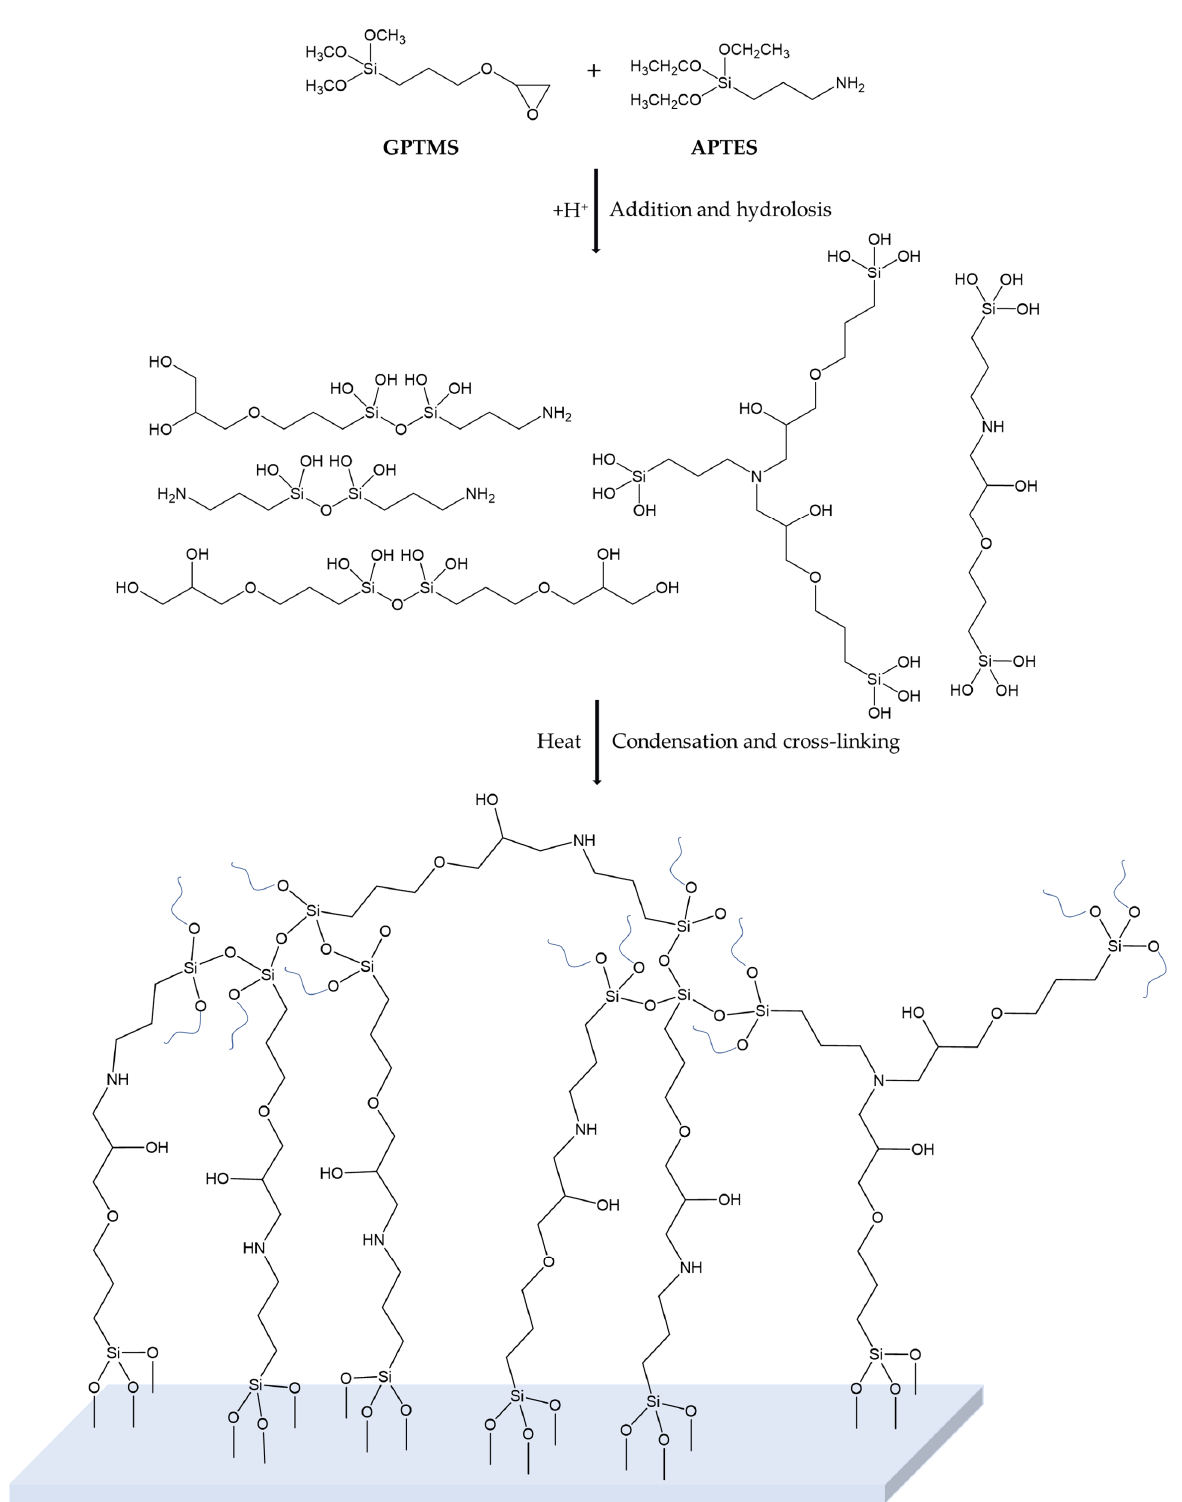
Figure 4. Sol–gel synthesis towards the formation of the cross-linked PEA-PEO-based G_A coating by reaction of G/A (2:1) [61].